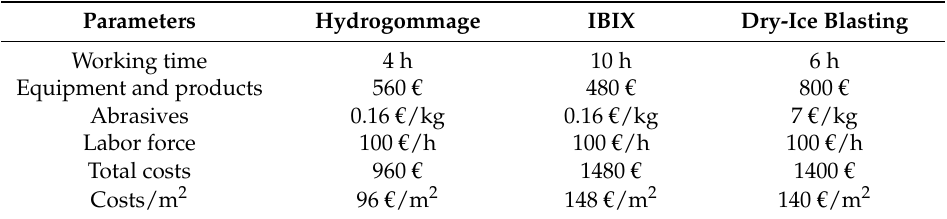
Table 3. Estimation of average costs for the different soft-blasting methods to clean graffiti paints on a wall (10 m 2